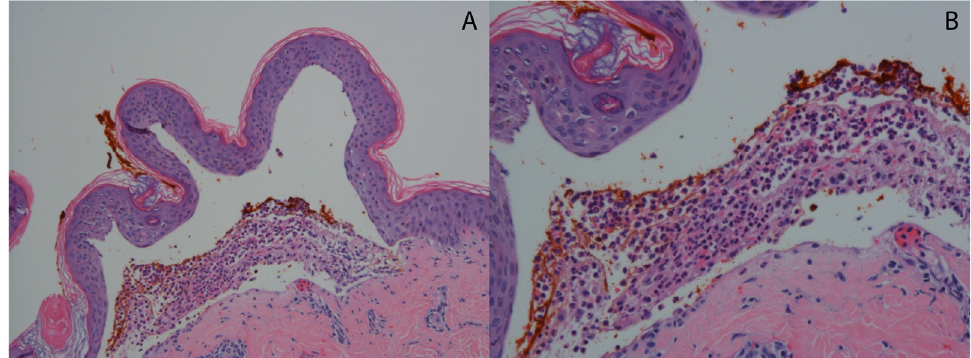
Figure 2. Typical histopathological findings in DH. ( A ) Hematoxylin and eosin-stained sample showing subepidermal separation (H&E 10×). ( B ) Hematoxylin and eosin-stained sample showing dense accumulation of neutrophils at the papillary dermis forming a microabscess (H&E 20×).